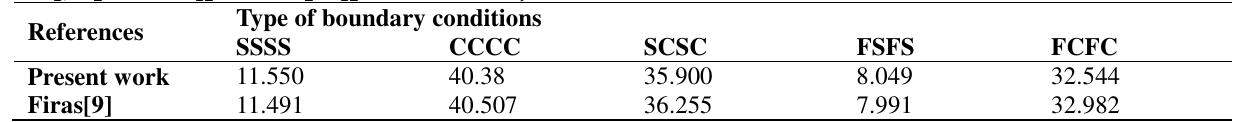
Non-dimensional buckling